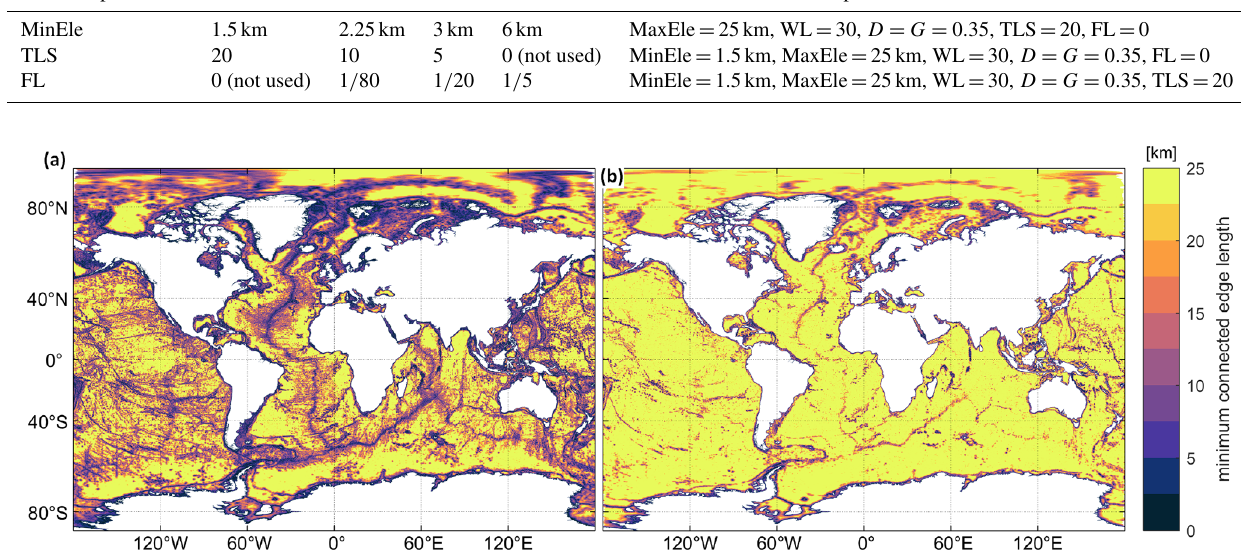
Figure 1. Mesh resolution distribution (defined as the minimum connected element edge length for a mesh vertex) for two global mesh designs: (a) Ref and (b) TLS-B (see Table